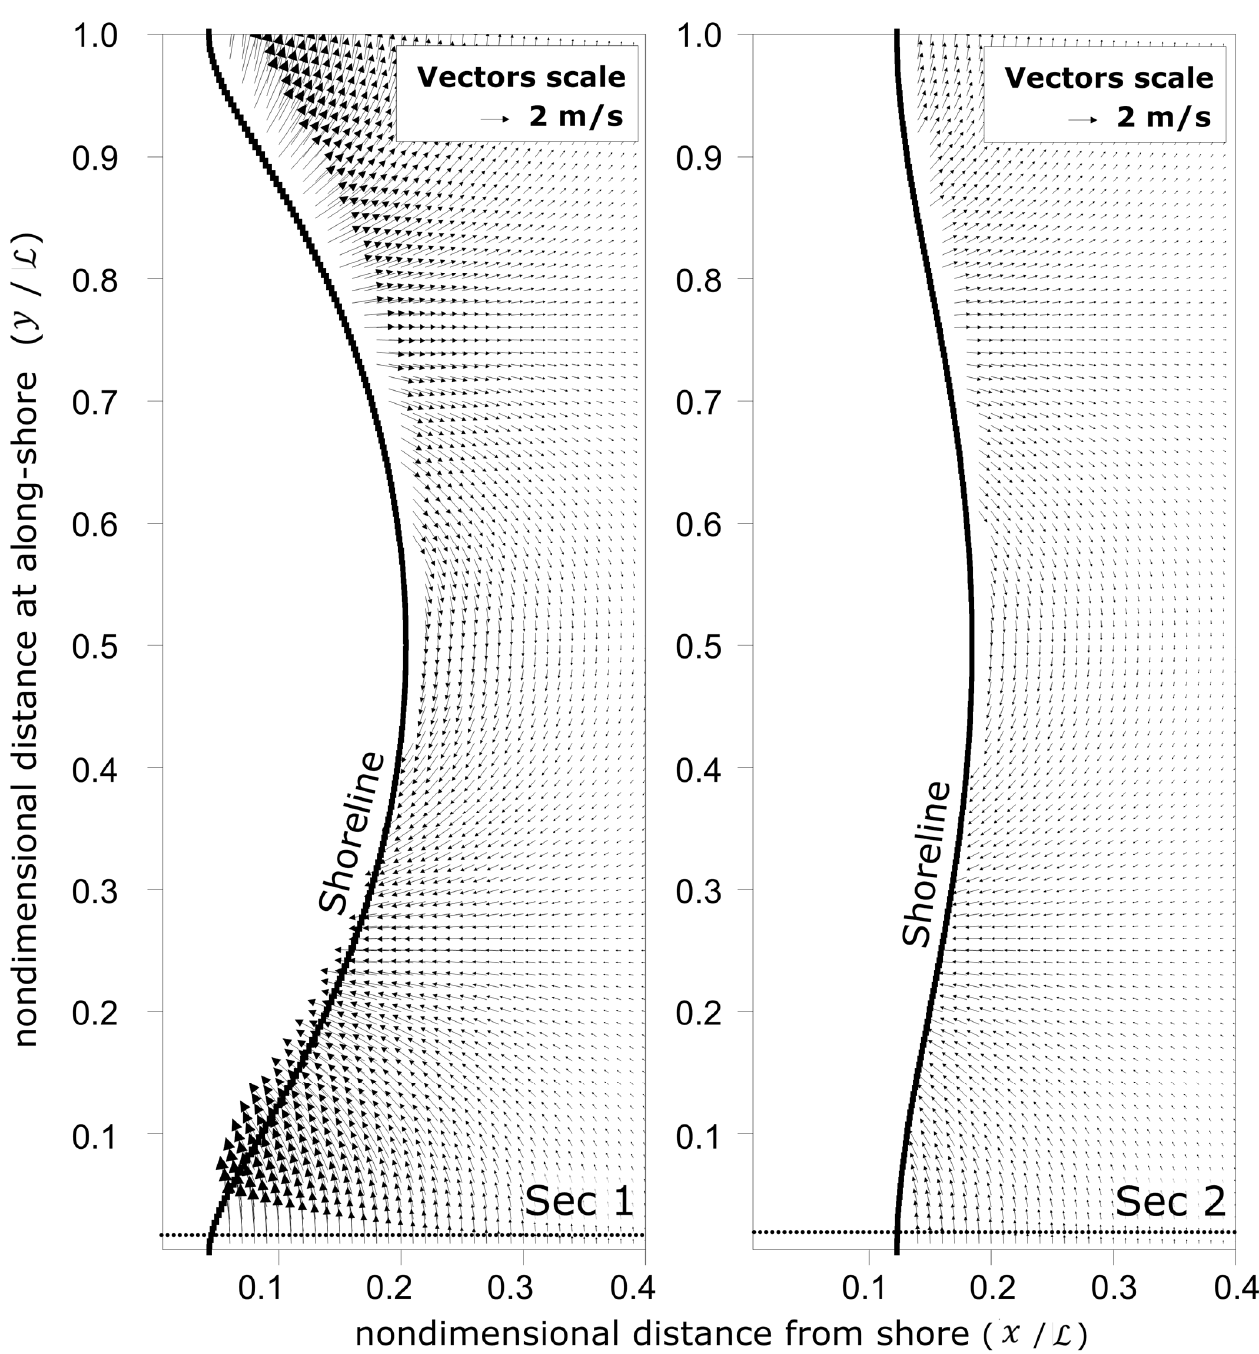
Figure 6. Flow field of progressive edge waves in the y axis: ( left : Case 1, right : Case 2).